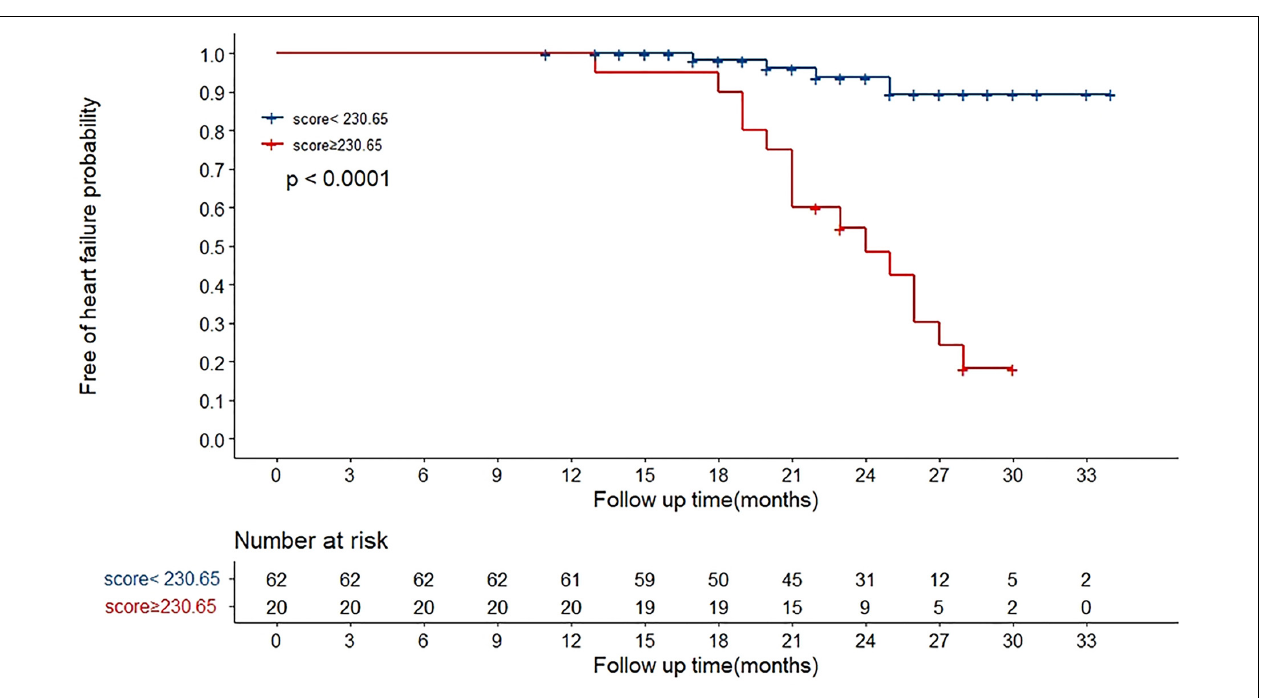
Supplementary Table 1 . The AUC values and C-index in the validation dataset were 0.991 (95% CI: 0.848–1.000, p < 0.001) ( Figure 6A ) and 0.941 (95% CI: 0.923–1.000), respectively.